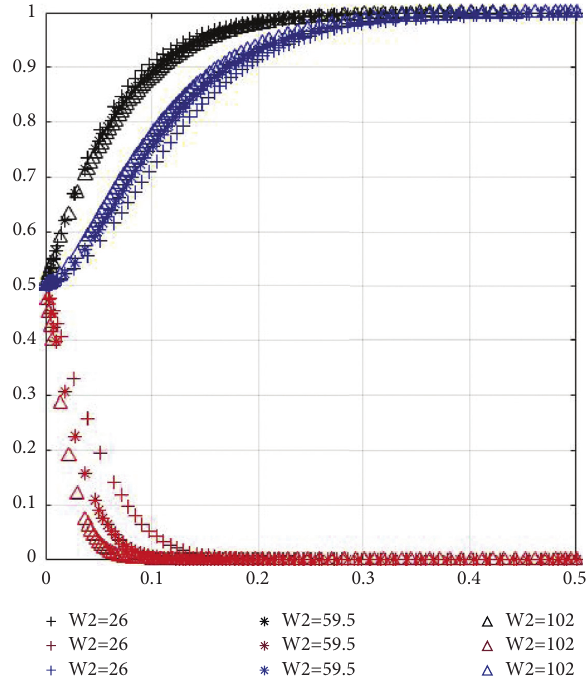
Figure 11: Loss of We Media publishing illegal information from small to large ( W 2 � 26 ⟶ W 2 � 59.5 ⟶ W 2 �